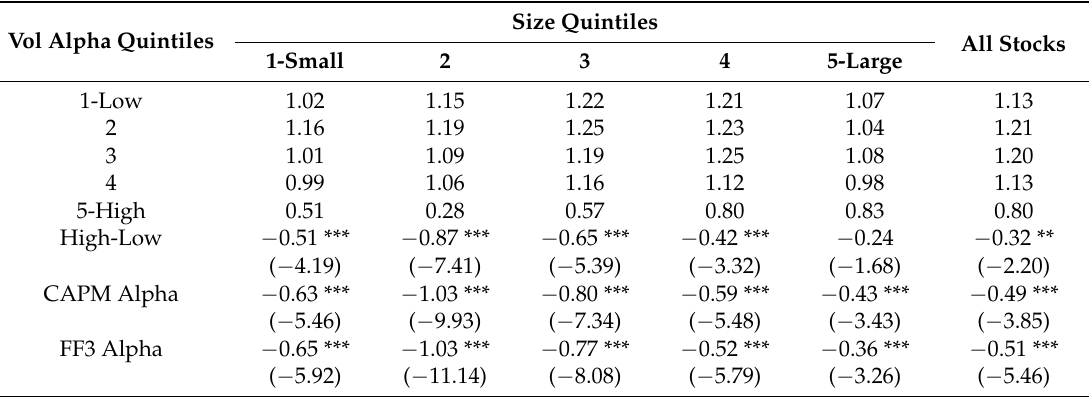
Table 2. Sort by Size and